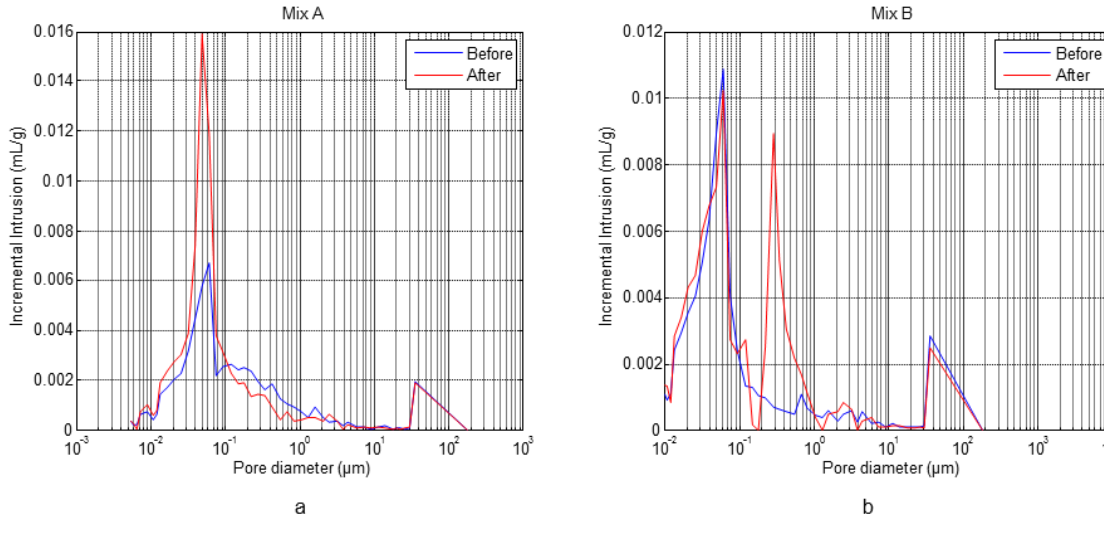
Figure 8. Pore size distribution of concrete before and after the cycles: ( a ) without air entrainment, ( b ) with air